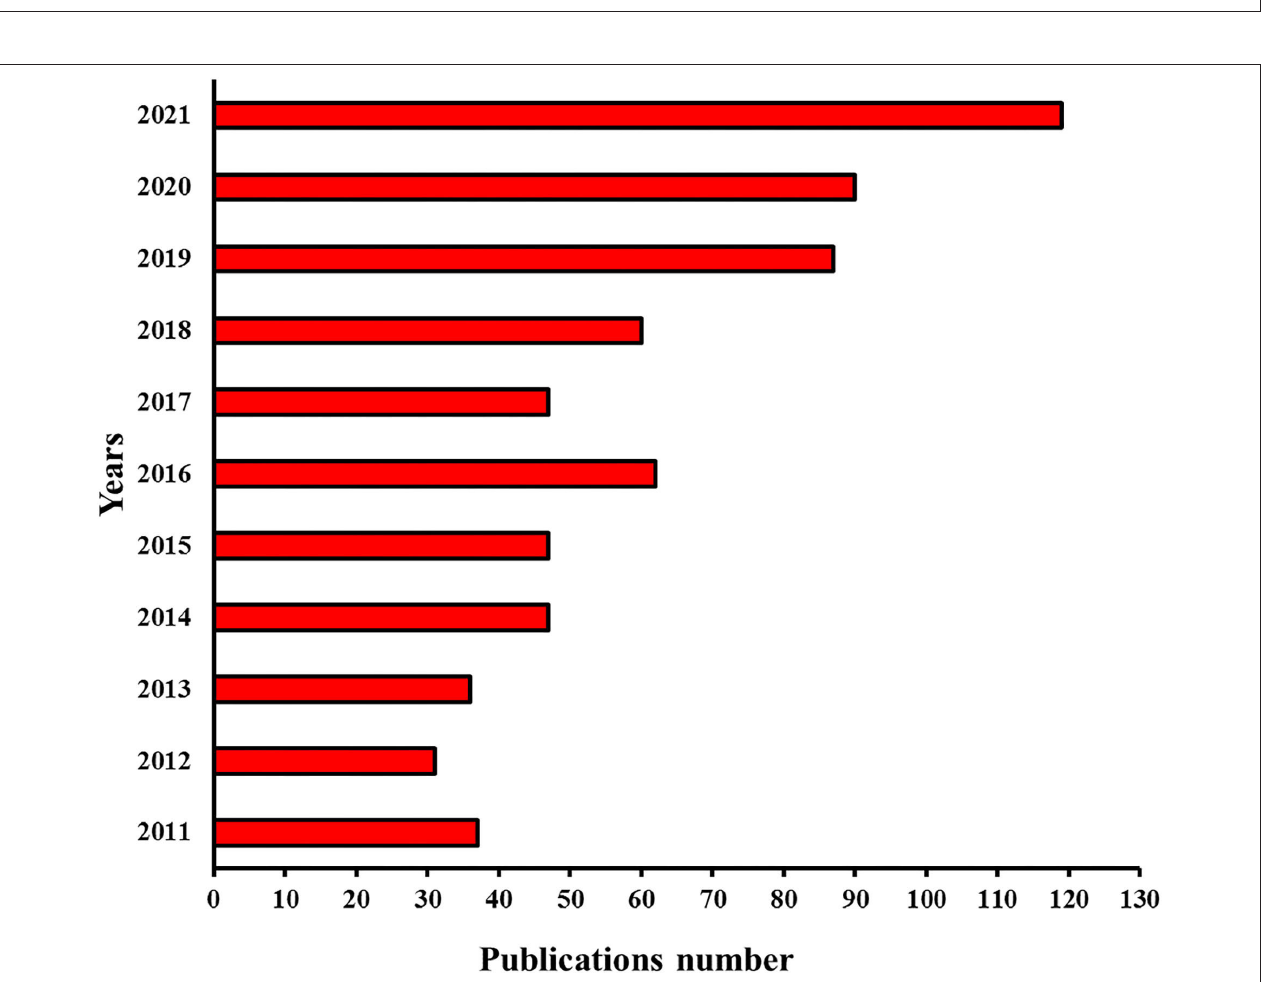
FIGURE 2 | Publications per year during the last 10 years (2011-2021) were analyzed by “Sci-finder” using “emulsion gel” as the keyword for searching.